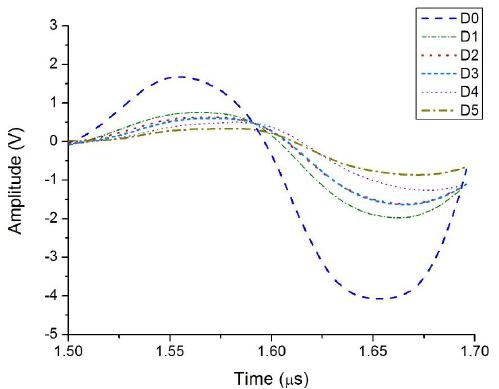
Figure 9. Main Waves extracted from 2nd trial on point 2 of undamaged state D 0 and damaged states